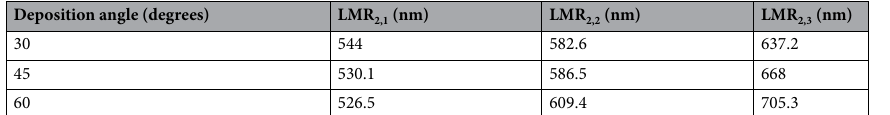
Deposition angle